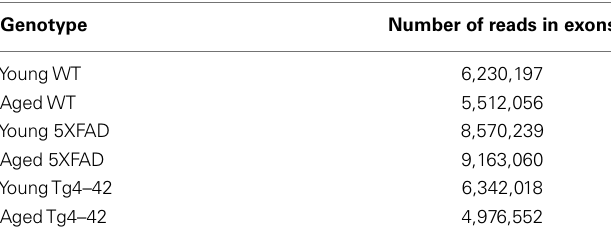
Table 1 | Number of exonic reads in brain tissue of wildtype and transgenic